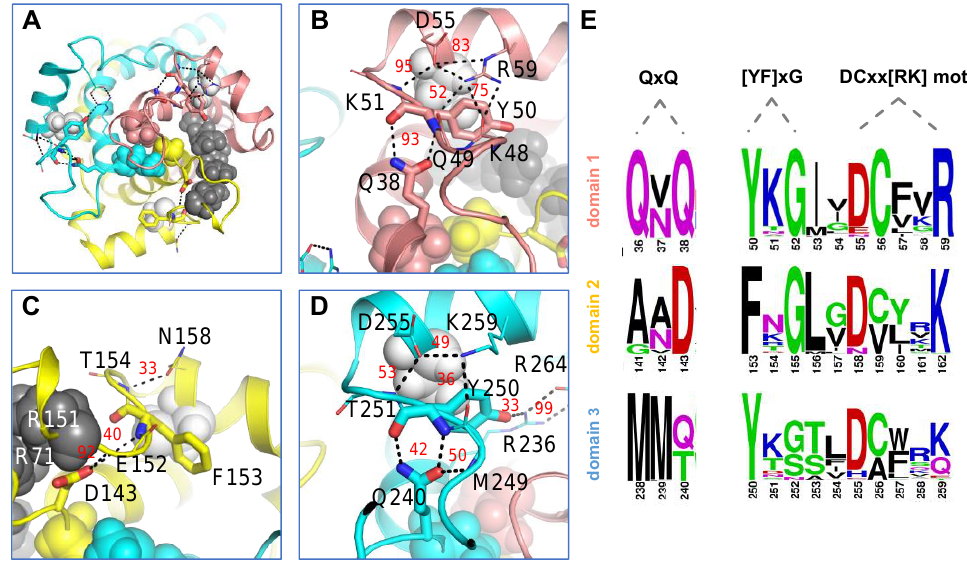
Figure 3. Intra-domain interactions between matrix loops and conserved MCF motifs in AAC. ( A ) Overall electrostatic interactions between matrix loops and conserved MCF motifs from the matrix side view. The conserved cysteine residues within the matrix helices, the R30:R71:R151 stacking structure and the hydrophobic plug are shown in white, black and colored spheres, respectively. Detailed interactions in domain 1, domain 2 and domain 3 are shown in ( B – D ), respectively. Electrostatic interactions are represented by black dashed lines, with the occupancies shown in red numbers. ( E ) Sequence logos of the QxQ motif, [YF]xG motif and DCxx[RK] motif in orthologs of AAC. The logos were generated by 43 sequences of various AAC subtypes from a total of 24 species (all sequences have been reviewed in UniProt). The residues are numbered based on bovine AAC1. In ( A – D ), the structures of domains 1, 2 and 3 are shown in salmon, yellow and blue, respectively. 2.3. Intra-Domain Interactions between the Matrix Loop and DCxx[RK] Motif in the Matrix